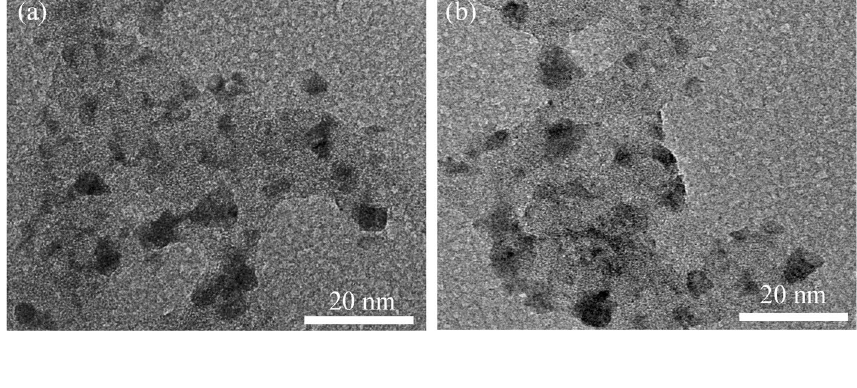
Fig. 2 HRTEM images (inset particle size distribution histograms) of CdTe particles for the samples, a S respectively